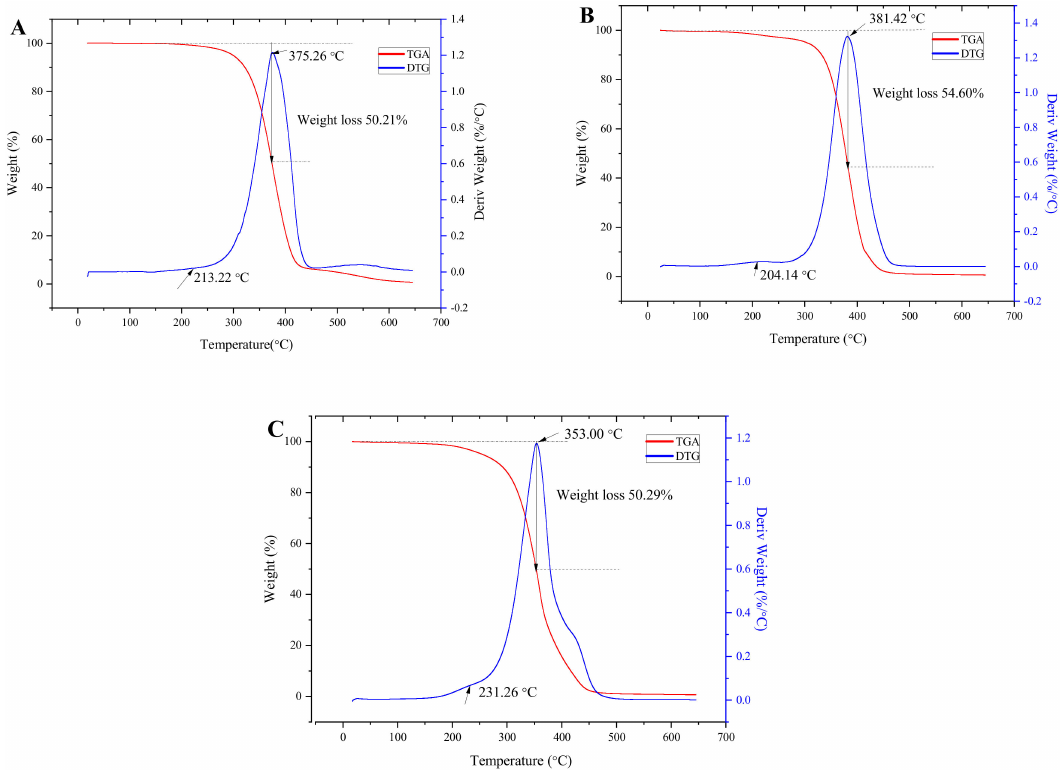
Figure 5. TGA and DTG curves of E. mollis oil obtained after three different processes: ( A ) UASEE, ( B ) SE, ( C )